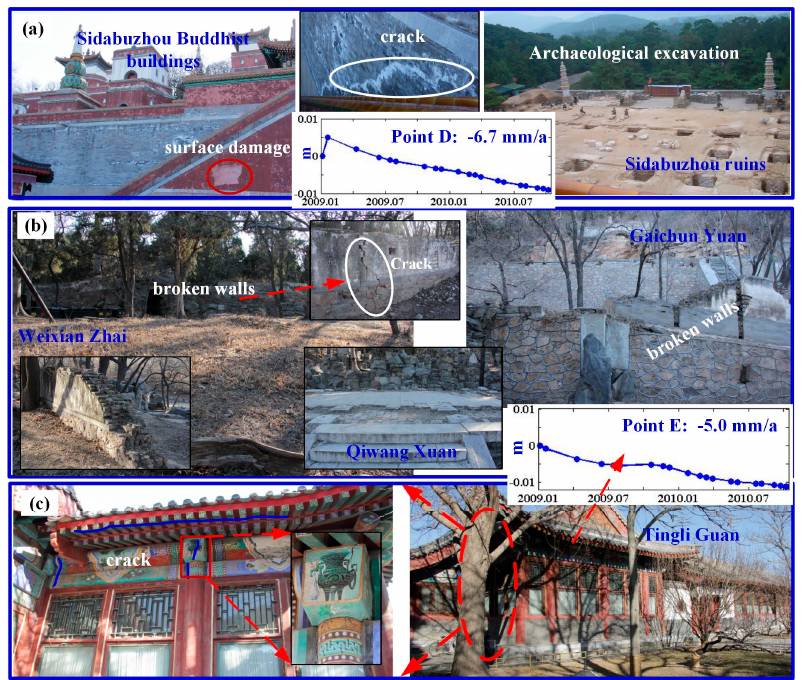
Figure 6. Photographs of Regions 2–4 marked in Figure 5a: ( a ) Region 2; ( b ) Region 3; and ( c ) Region 4. Displacement evolution of Points D and E (see Figure 5a for their locations) are illustrated by two sub-graphs.